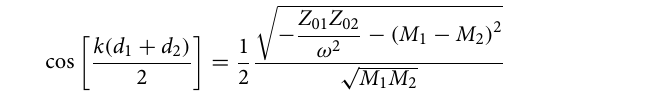
shows the existence of two passbands. Interestingly, using both the axial and the planar array results in the lower band being a forward wave branch and the upper band being a backward wave branch. It is important to note Z 02 Z 0 , d 1 d 2 d and M 1 M 2 M ) is equivalent to that the degenerate case (i. e. the case with Z 01 = = = = = = a monoatomic array, so both descriptions of a monoatomic array are compatible, taking into account that the lattice period in the diatomic array is twice that of the monoatomic array, and using the usual rules of folding for Brillouin zones for waves in periodic structures 43 . This is illustrated in Fig. 9 using a planar array as an exam- ple. Figure 9a shows the familiar backward-wave dispersion of a monoatomic planar MI array, with the lattice constant d , with the Brillouin zone range of kd from 0 to π . Figure 9b shows the degenerate diatomic dispersion for the same array, with the lattice constant d now doubled and the dispersion seen to have folded into the 1 st Brillouin zone forming a forward-wave and a backward-wave branch. This leads us to a simple possibility for implementing a switchable power flow. Treating monoatomic arrays as degenerate diatomic arrays, we shall implement near-field interference exciting not two neighbouring meta- atoms, but two neighbouring unit cells instead. In this case the analysis of Eq. (11) is still valid. In Fig. 10 we 27 , show the variation of P l / P r as a contour plot on the (ψ , ω) parametric plane for the the planar array with N = excitation on elements 13 and 15 with a phase shift of ψ and using the same coupling coefficient as in Fig. 2 0.13 and assuming again that reflections from the ends are eliminated by using the matched loads. (b), κ = − Figure 10 verifies that by exciting non-adjacent elements the near-field interference would indeed enable the switching of the power flow directions. For the phase shift in the positive range of 0 < ψ < π , if the frequency is below the resonant frequency, the power would flow mostly to the right (corresponding to the forward-wave type), but switching to a frequency above the resonant frequency would enable the power to flow mostly to the left (corresponding to the backward- π < ψ < 0 swaps the directions of the power wave type). Changing the phase shift to the negative range of − flow. White dashed lines show the conditions of the complete suppression of the power flow as dictated by Eqs. (10 and 11) and they can be seen to accurately predict the phase shift-frequency relationship for the unidirec- tional power flow. We have carried out the experiment confirming the switchable power flow – the setup is exactly the same as exp ( j π/ 2 ) , V 15 1 ). before, with the only difference being that elements 13 and 15 are now being excited ( V 13 = = The results are summarised in Fig. 11 both for the axial and for the planar array. The experimentally found current distributions for both arrays are shown in Fig. 11a and b and the corresponding theoretical results from Eq. (3) are shown in Fig. 11c and d and can be seen to match well the experimental data. As can be seen, by exciting non-adjacent elements 13 and 15 with the right phase difference, our array can be regarded as a diatomic one which can support both a forward wave and a backward wave. In the lower-frequency forward-wave band the power travels to the right end and in the higher-frequency backward-wave band the power travels towards the opposite, left end of the structure. The switch occurs when the frequency changes. Potentially, this phenomenon can have application as a channel dropping filter.